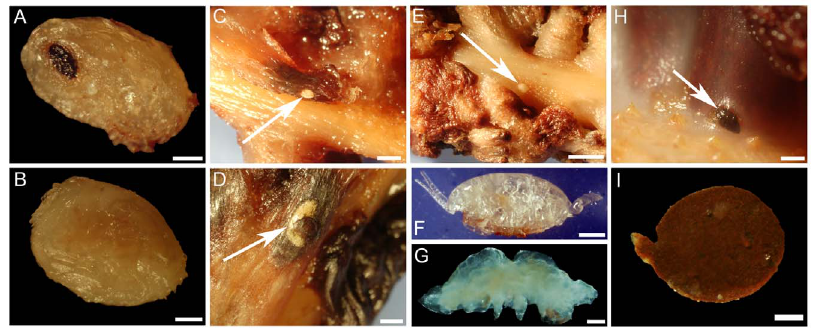
Figure 2. Associates of Anthoptilumgrandiflorum : (A) decapod larva, (B) unidentified sp. 3, (C) unidentified sp. 1, (D) unidentified sp. 4, (E) unidentified sp. 2, (F) unidentified copepod. Unidentified sp. 1 to 4 correspond to potential egg mass. Associates of Halipteris finmarchica : (G) unidentified Lamippidae, (H and I) unidentified sp. 7. Scale bar in A=200 m m, B, F and H=500 m m, C and D=2 mm, E=4 mm, I=100 m m. Species numbers linked to Table 2.